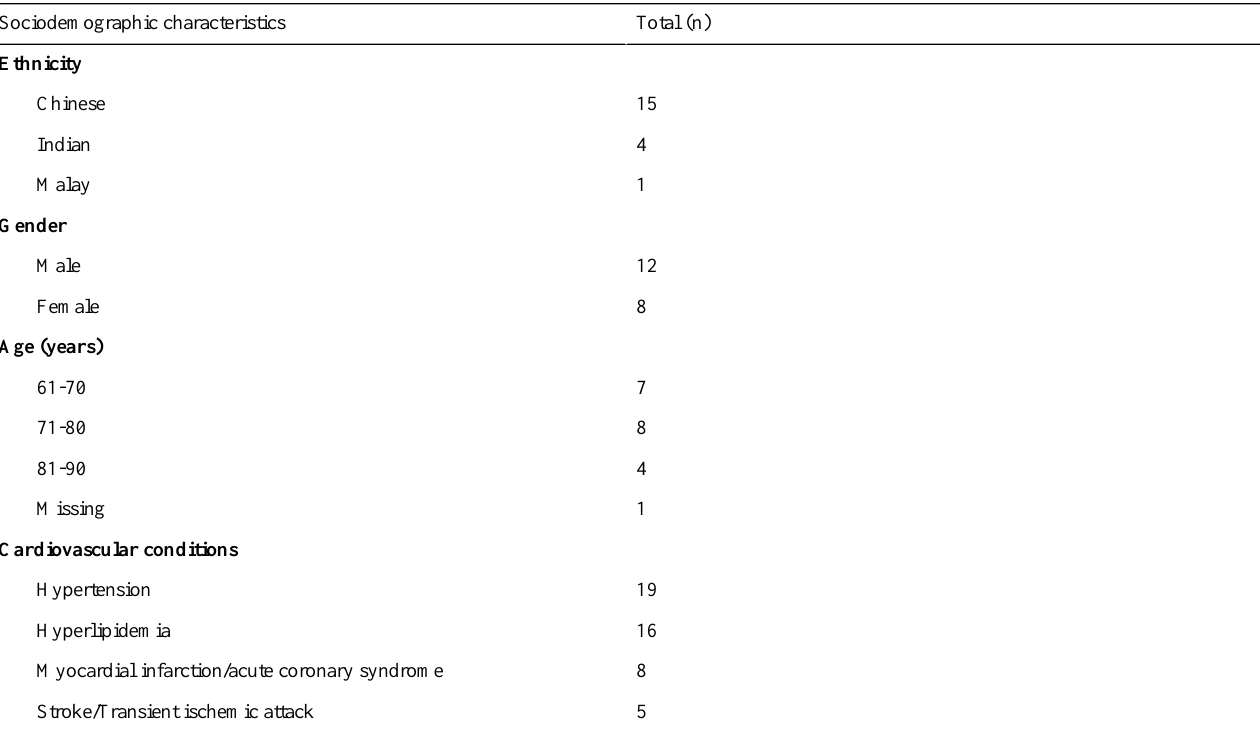
Table 2. Qualitative participant characteristics table